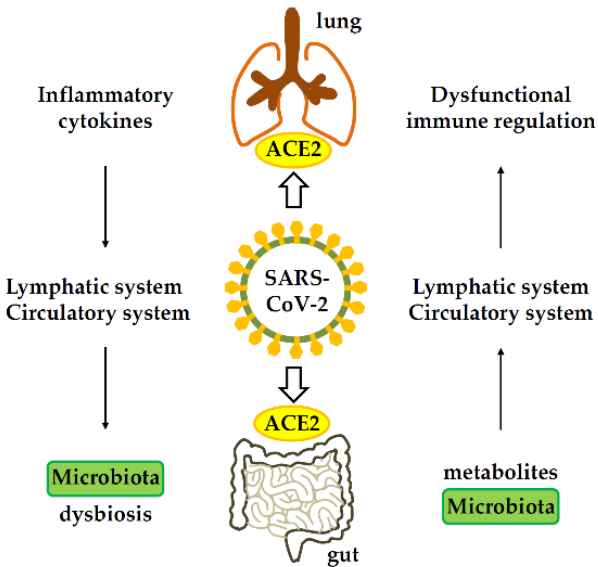
Figure 6. Gastrointestinal-lung axis in COVID-19. ACE2, angiotensin-converting enzyme 2.